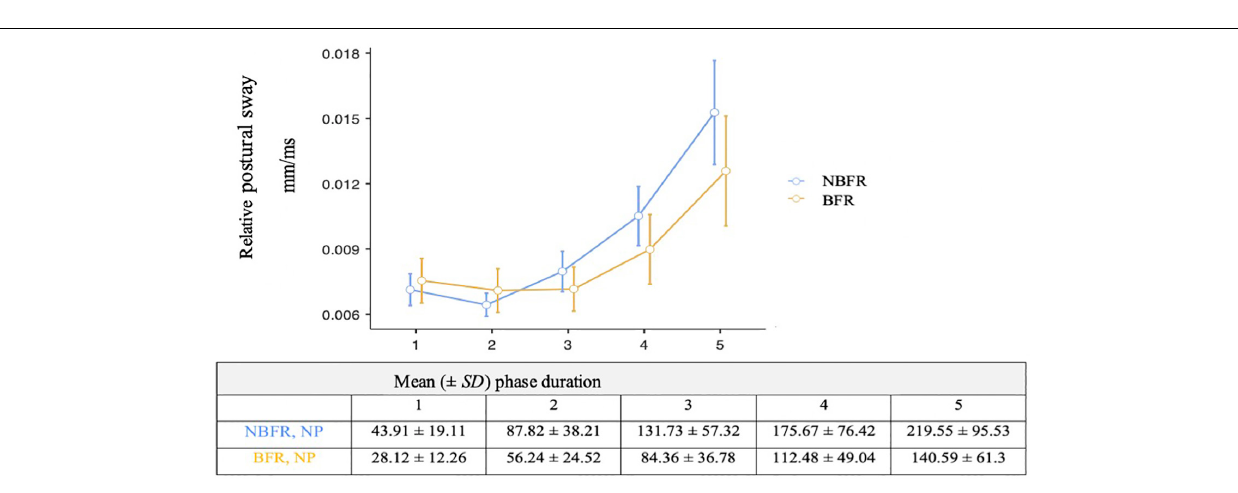
FIGURE 4 | Analysis of relative postural sway and measurement duration in the non-perturbated condition. Mean value comparison and 90% CI of the relative postural sway. NBFR = No BFR. N = 20 in all